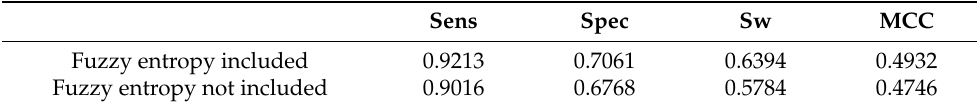
Table 9. Influence of fuzzy entropy on SVM-FE prediction results.